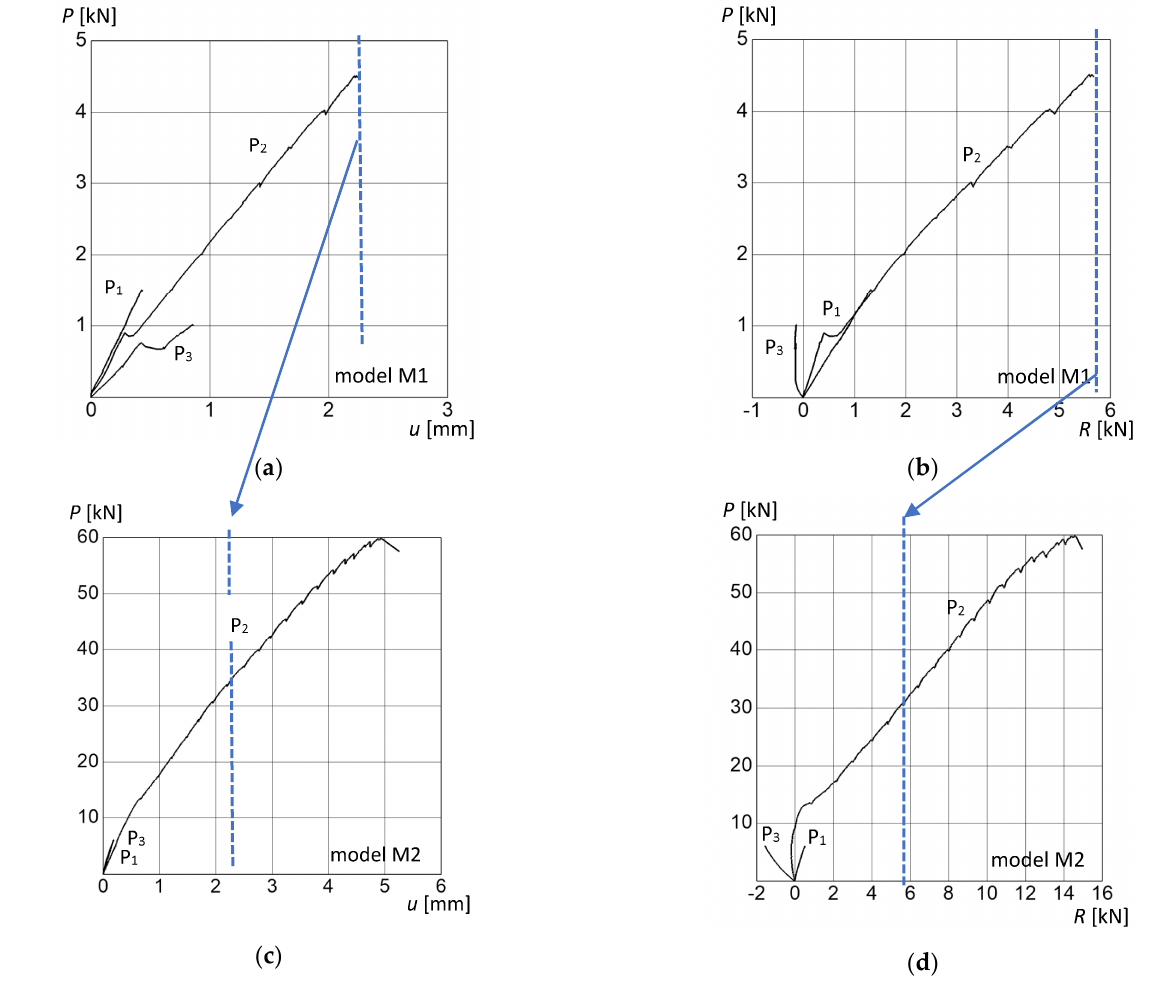
Figure 10. Experimental results of masonry staircases: relation P–u (vertical displacement in the middle of an arch in point P 2 ) for model M1 ( a ); force P –reaction R for model M1 ( b ); force P –displacement u (vertical displacement in the middle of an arch in point P 2 ) for model M2 ( c ); force P – reaction R for model M2 ( d ).